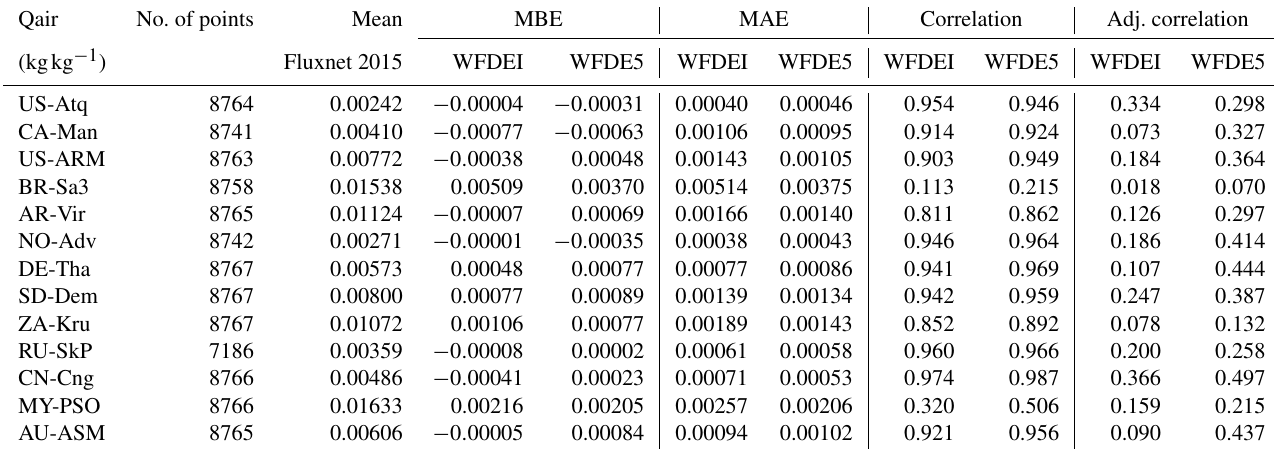
Table A11. Qair metrics for each FLUXNET2015 site: WFDEI versus FN2015 and WFDE5 versus FN2015 at 3-hourly time steps. Qair No. of points Mean Correlation Adj.